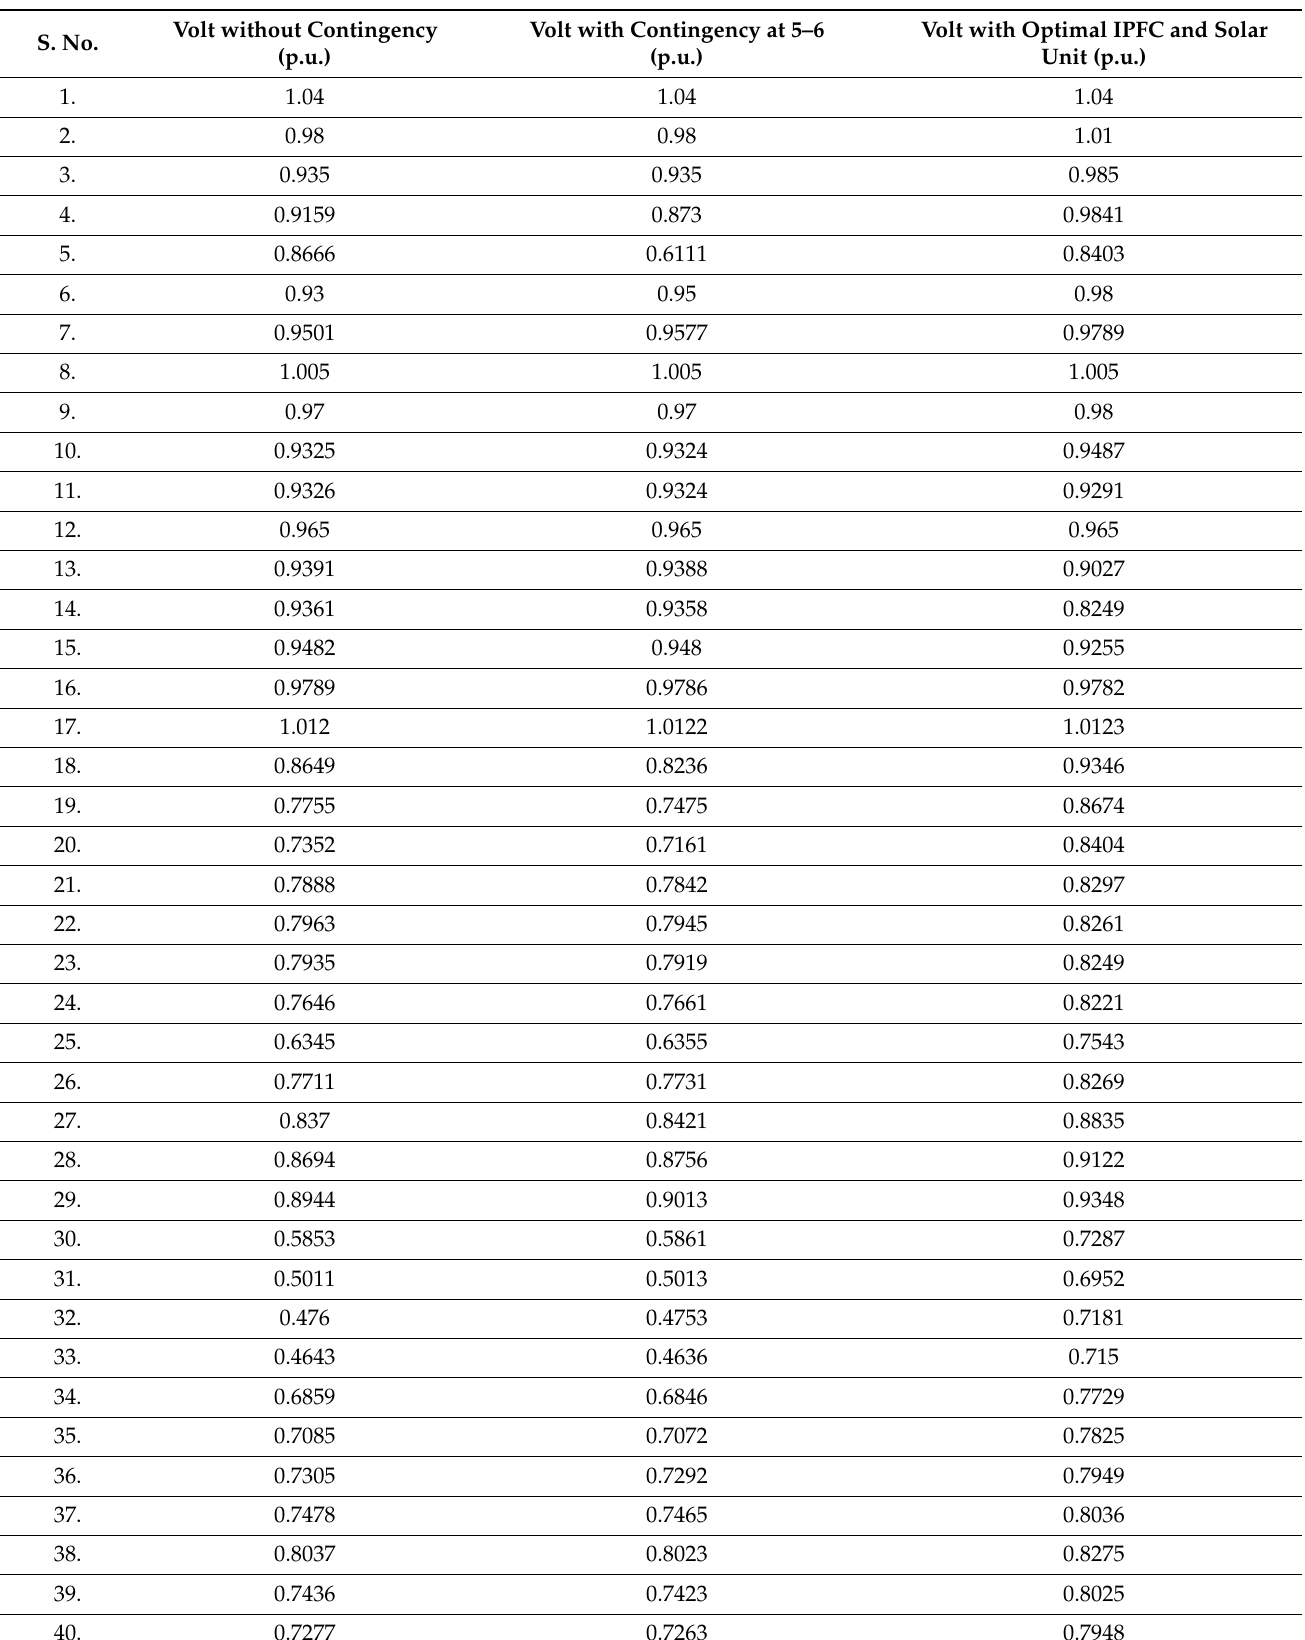
Table 7. Voltage Deviation of